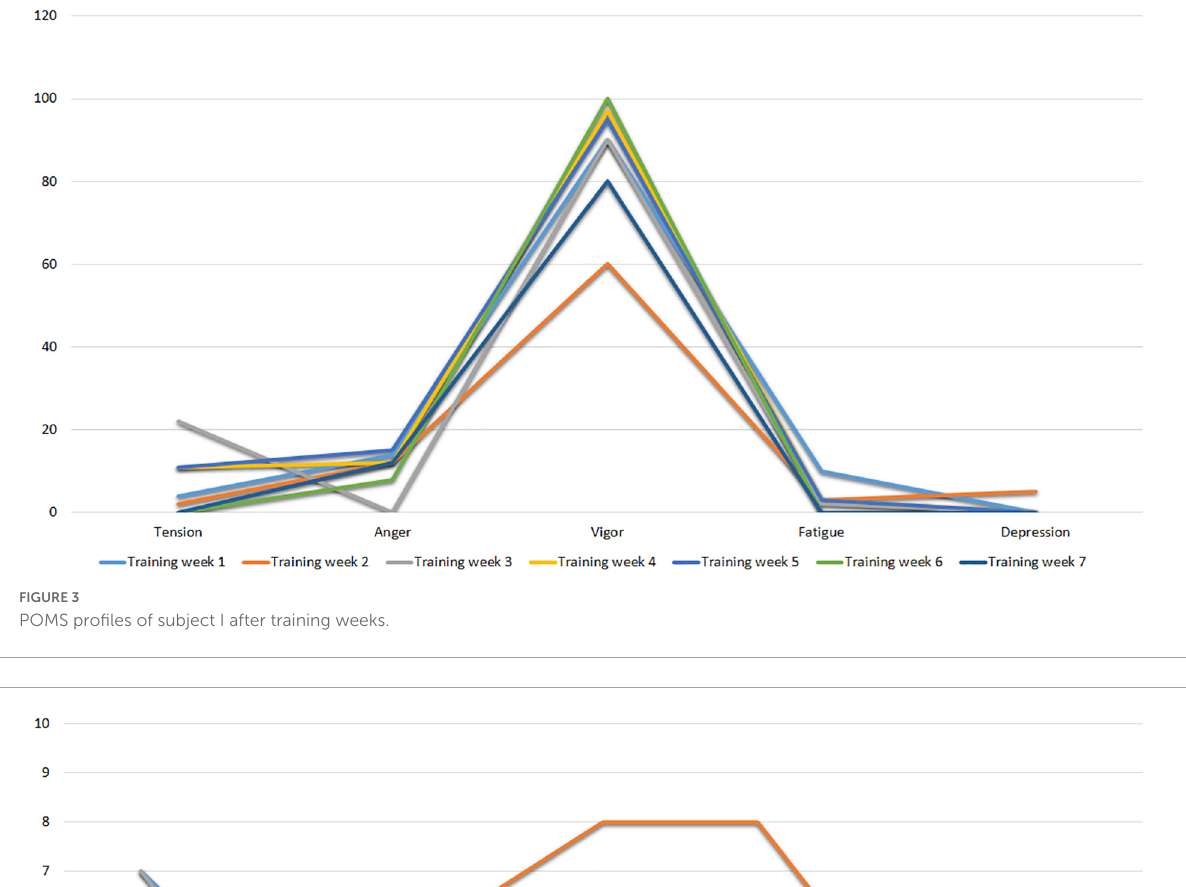
FIGURE3 POMS profiles of subject I after training weeks.